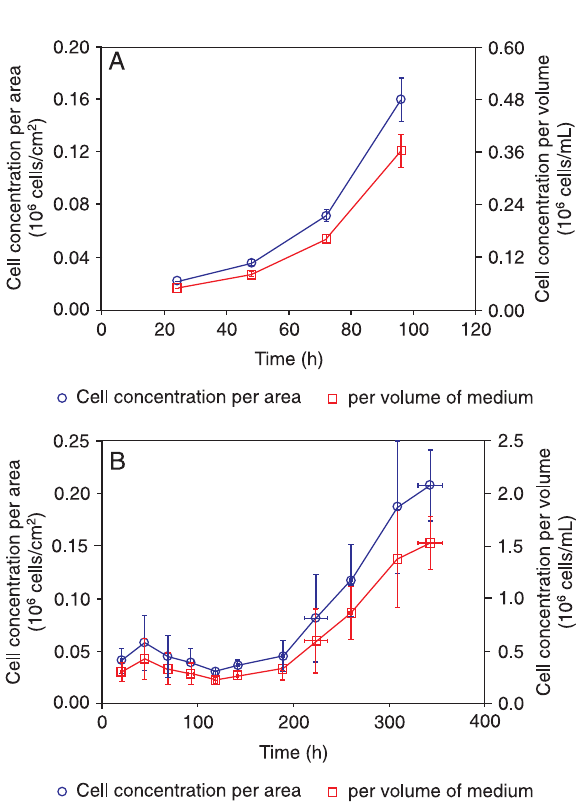
Figure 1. Kinetics of human embryonic stem cell growth